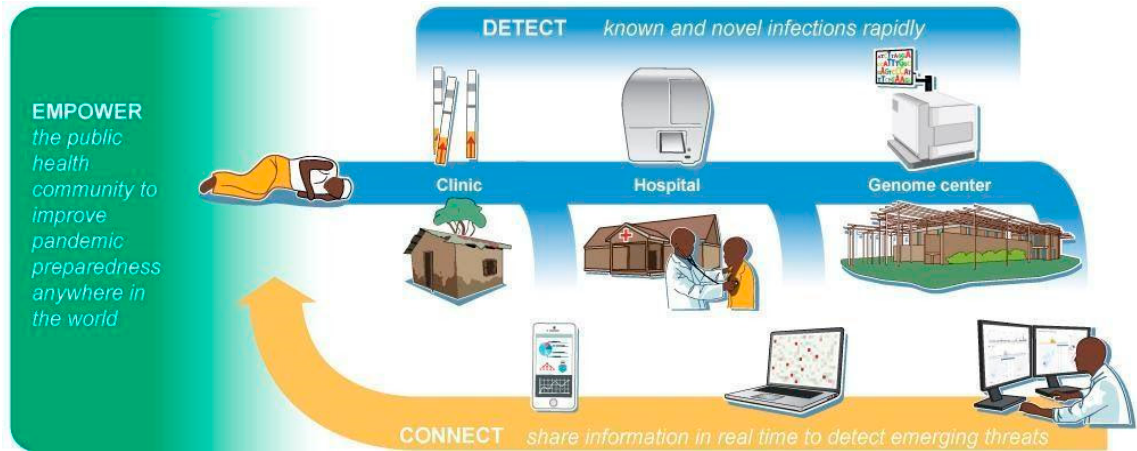
Figure 1. Sentinel will detect pathogens in any setting, from remote rural clinics to hospitals, and unknown pathogens will be identified and characterized at regional genome centers. Through a cloud-based system, Sentinel will share this information and connect healthcare workers, researchers, and disease control officials to track and predict threats. Finally, Sentinel will empower all stakeholders through a codified pandemic preemption system that can be scaled around the world.